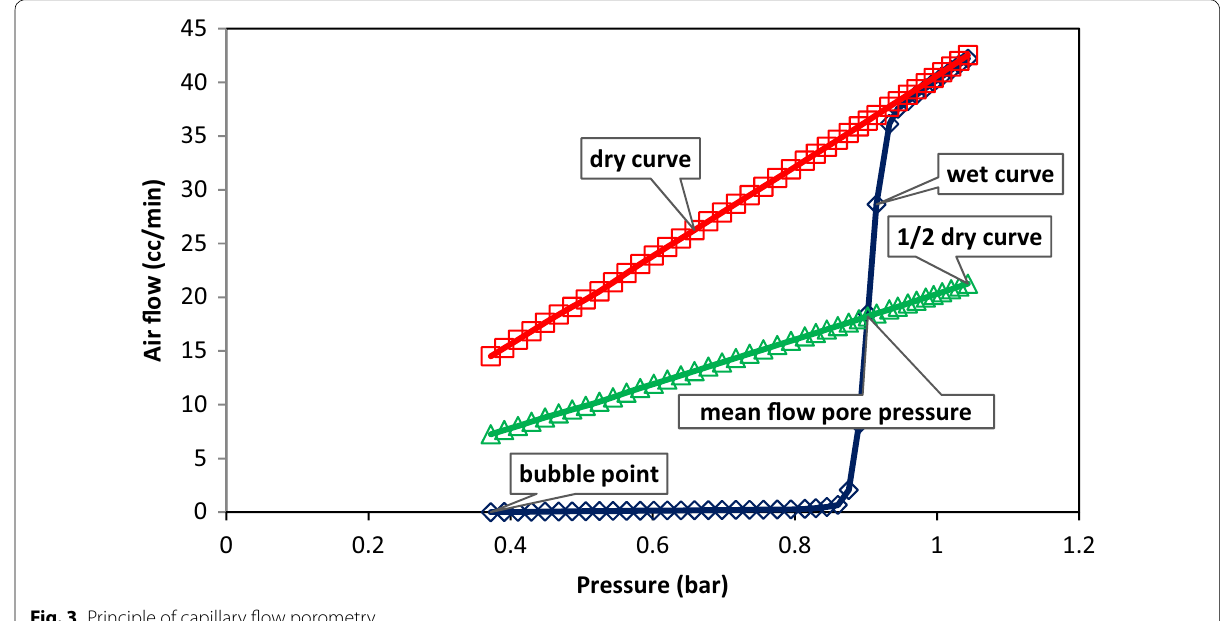
Fig. 3 Principle of capillary flow